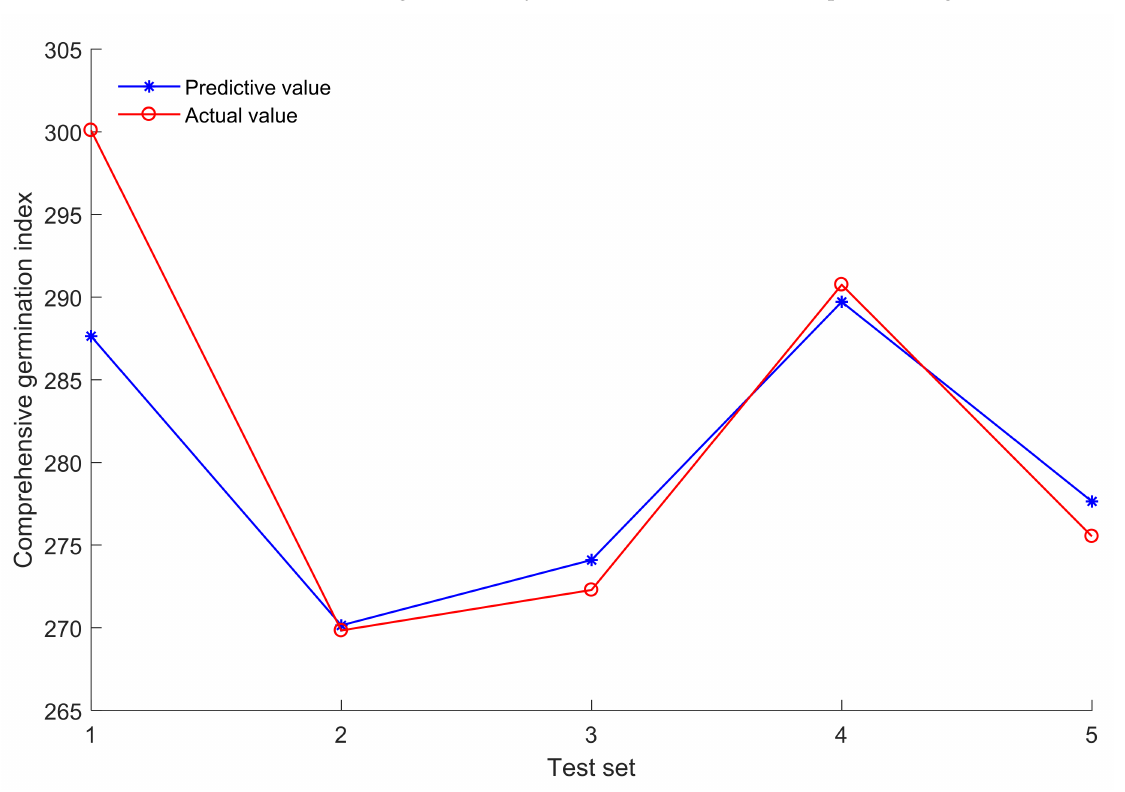
Figure 5. Test results of hybrid WOA–SVR for seed comprehensive germination